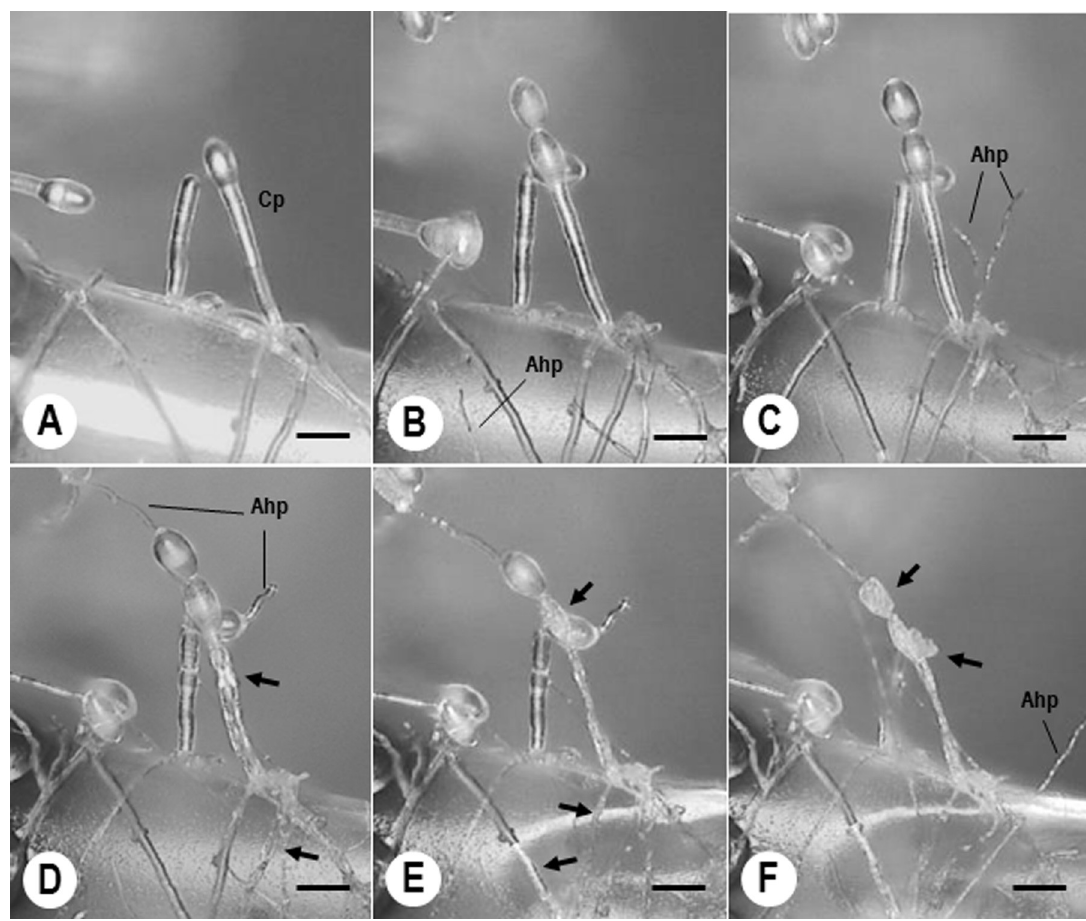
Fig 4. Infection process of Ampelomyces strain Xs-q in tomato powdery mildew KTP-03. KTP-03 vigorously grew on tomato type I trichome cells. Digital micrographs were taken at 0 (A), 2 (B), 3 (C), 5 (D), 6 (E) and 7 days (F) after inoculation of a pycnidium onto tomato leaf in the vicinity of the trichome cells. KTP-03 conidiophores (Cp) and hyphae (arrowed) atrophied after invasion of Xs-q hyphae (Ahp) into KTP-03 hyphae. Bars represent 20 μ